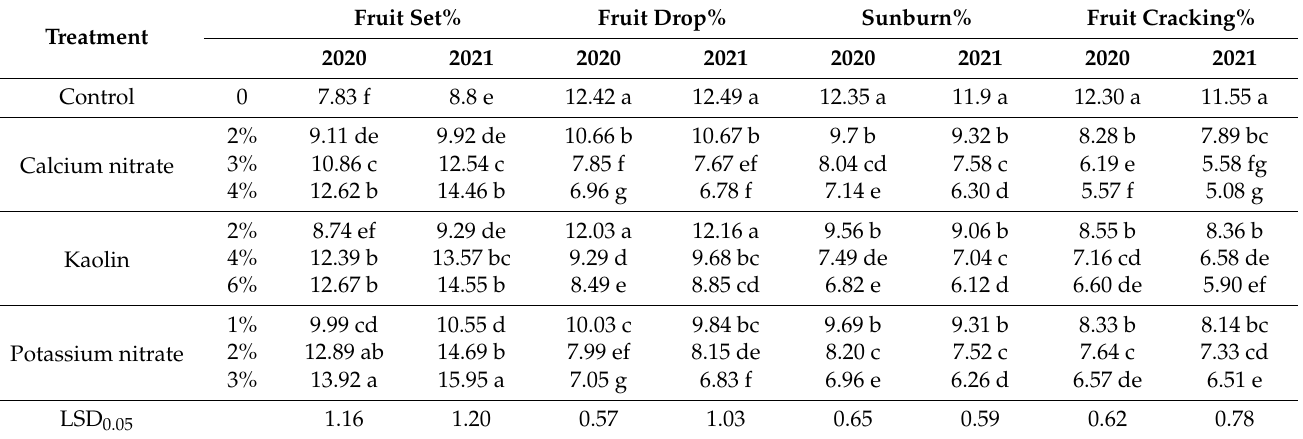
Table 2. The effect of the foliar application of potassium nitrate, calcium nitrate and kaolin on the fruit set, drop, sun burn and cracking percentages of ‘Wonderful’ pomegranate during the 2020 and 2021 seasons.